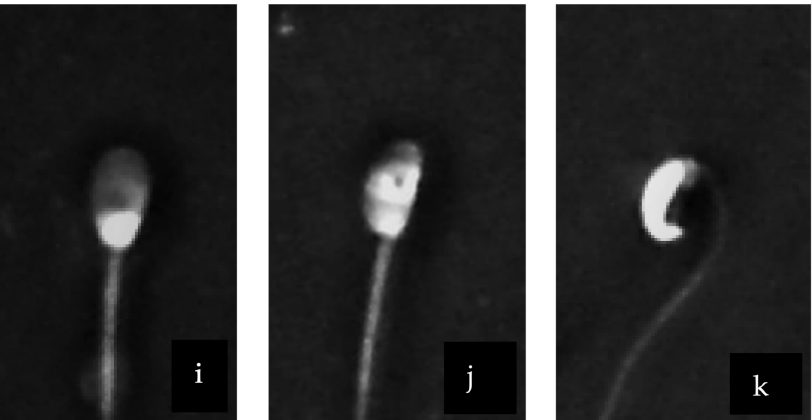
Figure 2. Sperm morpho-abnormalities of donkey using Trumorph ® technique at 400 × magnifica- tion. ( a ) Roughed mid-piece; ( b ) macrocephaly with bend mid-piece; ( c ) segmental aplasia of the mitochondrial sheet in the middle; ( d ) protrusion of axonemal fiber; ( e ) distal cytoplasmic droplet ( f ) distal coiled tail with retained cytoplasm; ( g ) coiled tail with retained cytoplasm; ( h ) abnormal tail formation; ( i ) normal head with defined acrosome; ( j ) nuclear vacuole in the head; ( k ) head with cytoplasmic invagination and aplasia of mid-piece. Scale bar in ( a ) applicable to all micrographs